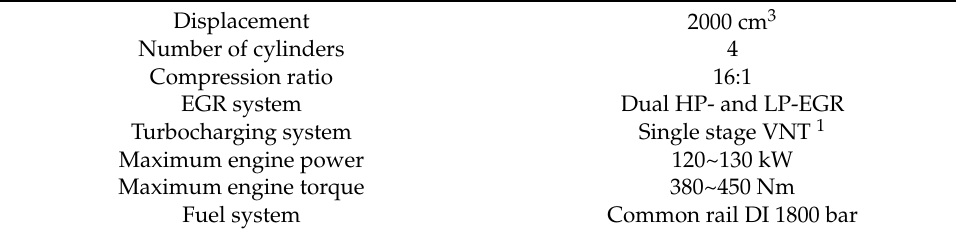
Table 1. Specification of the reference engine.